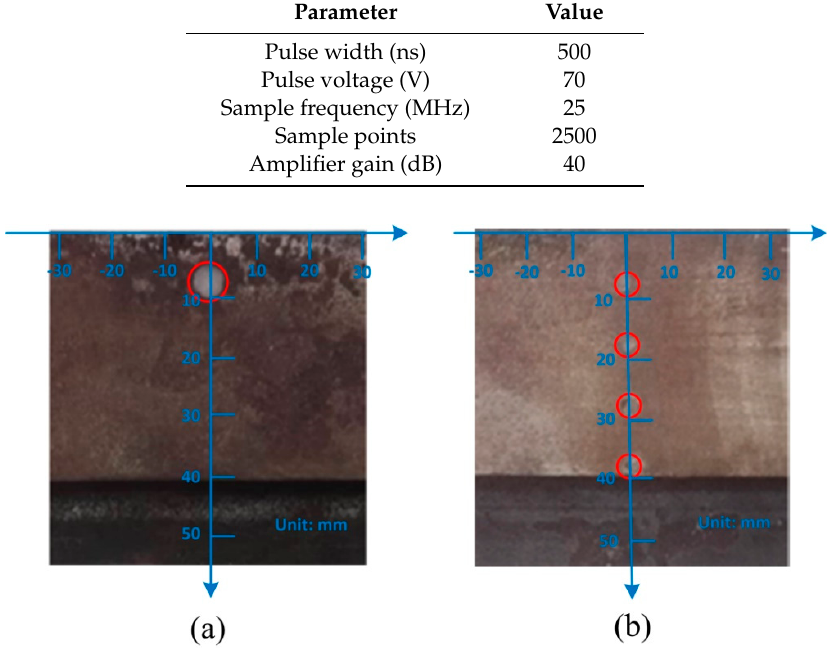
Figure 4. Cross-section of rails: ( a ) Specimen 1; ( b ) Specimen 2.